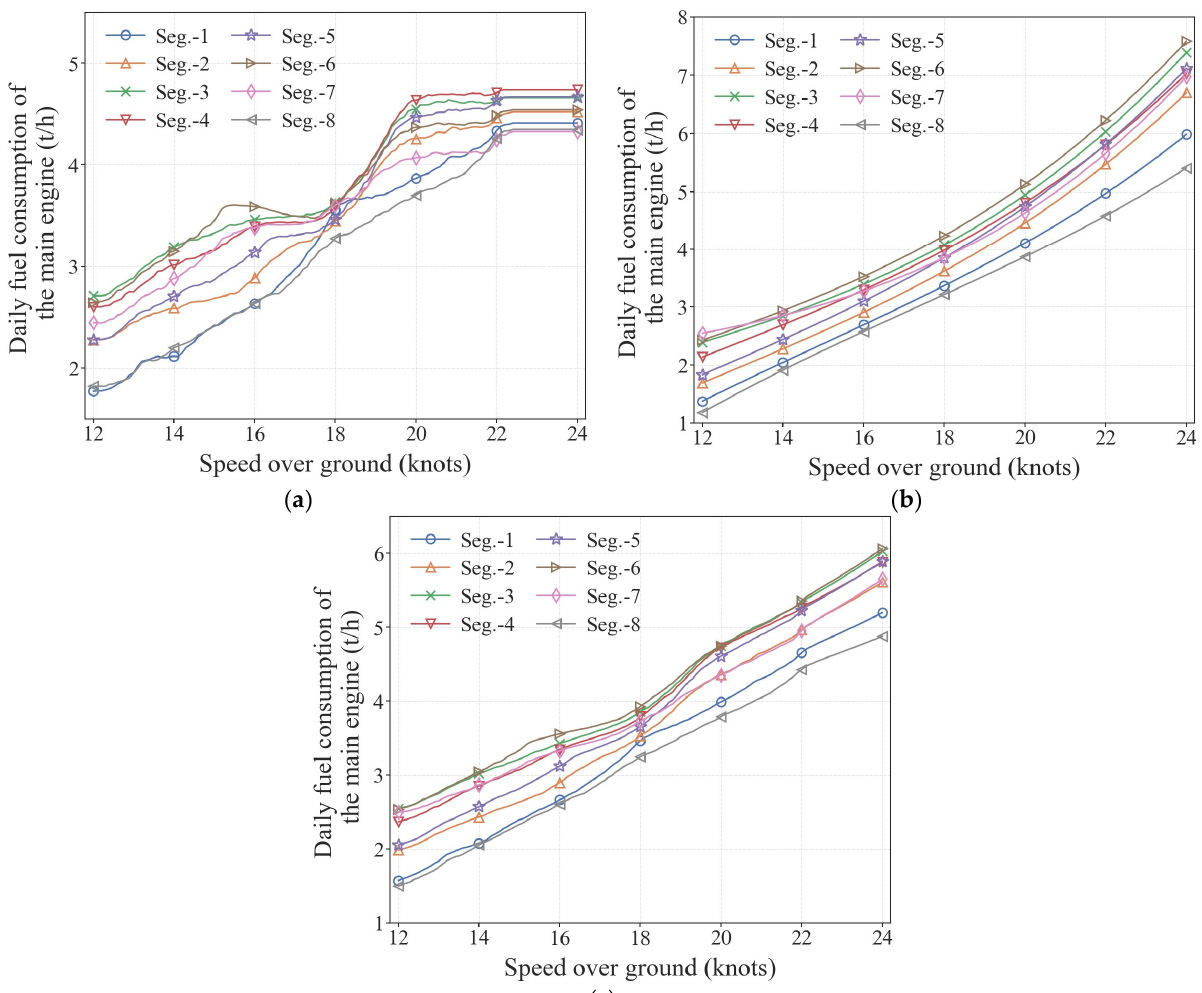
Figure 2. Trend reliability differences before and after fuel consumption model integration on test segments. ( a ) ET model. ( b ) PR model. ( c ) VR